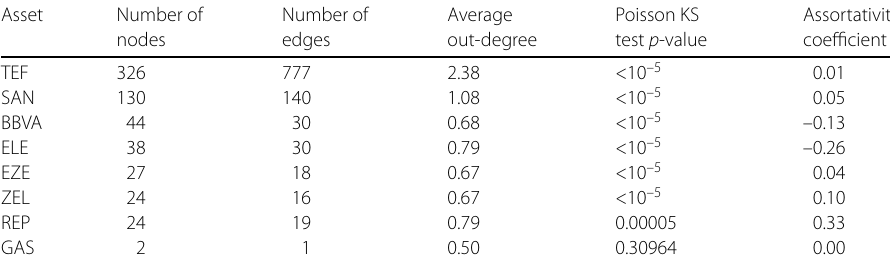
Table 2 Anticipation network features. Number of nodes, edges and average degree are shown in the first three columns for all networks. Fourth column refers to a Null Hypothesis testing based on Kolmogorov–Smirnov (KS) statistic for rejecting the hypothesis that underlying distribution for node out-degrees is a Poisson distribution, only p -value is shown. Fifth column shows the Degree Assortativity of the directed graph. The networks in this table have been built using “FDR” as described in methods section. Similar results can be found when using Bonferroni (see table S2) Asset Number of Number of Average Poisson KS nodes edges out-degree test p